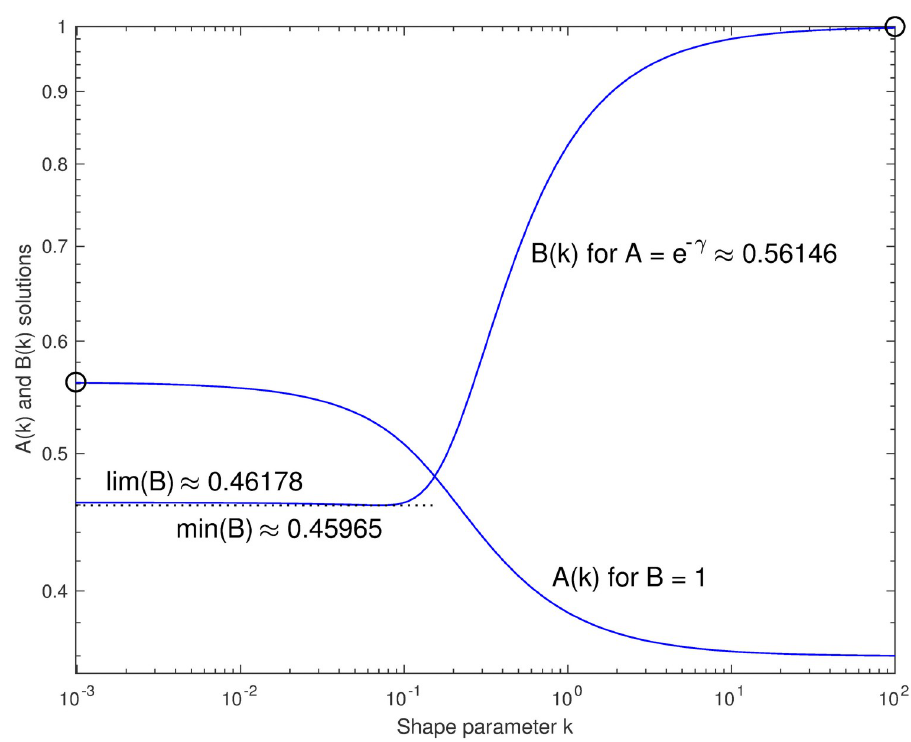
Fig 7. Ideal parameters as functions of k . Functions A ( k ) and B ( k ), either of which can solve ν ( k ) = 2 − 1/ k ( A + Bk ), with the other constant at the limiting values indicated by the circles, the parameters of ν curves can lead to better bounds or